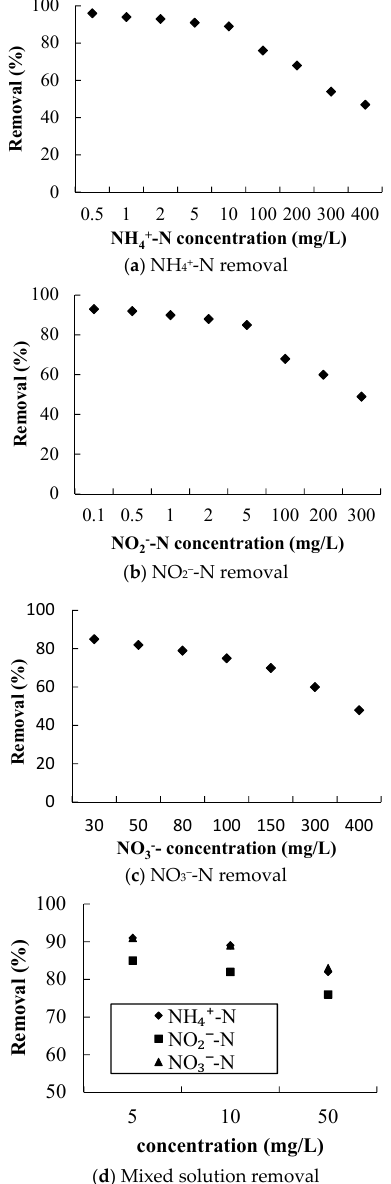
Figure 2. Nitrogen removal in different concentrations.